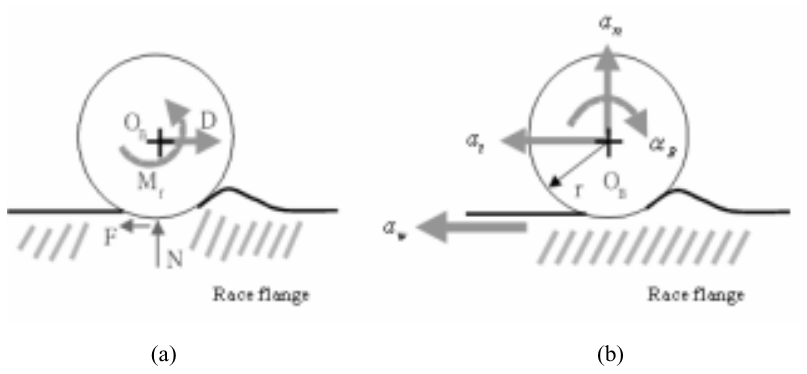
Fig. 3. Free-body diagram of balancing ball. (a) Force equilibrium of the ball. (b) Definitions of ball